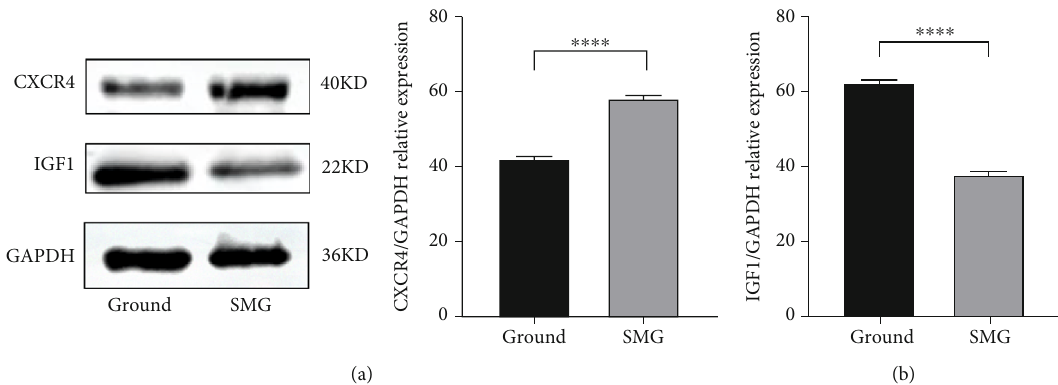
Figure 7: Validation of hub genes under weightlessness osteoporosis. Western blotting analysis of CXCR4 (a) and IGF1 (b) protein expression level in BMSCs after 48 h simulated microgravity. Data are presented as mean ± SD